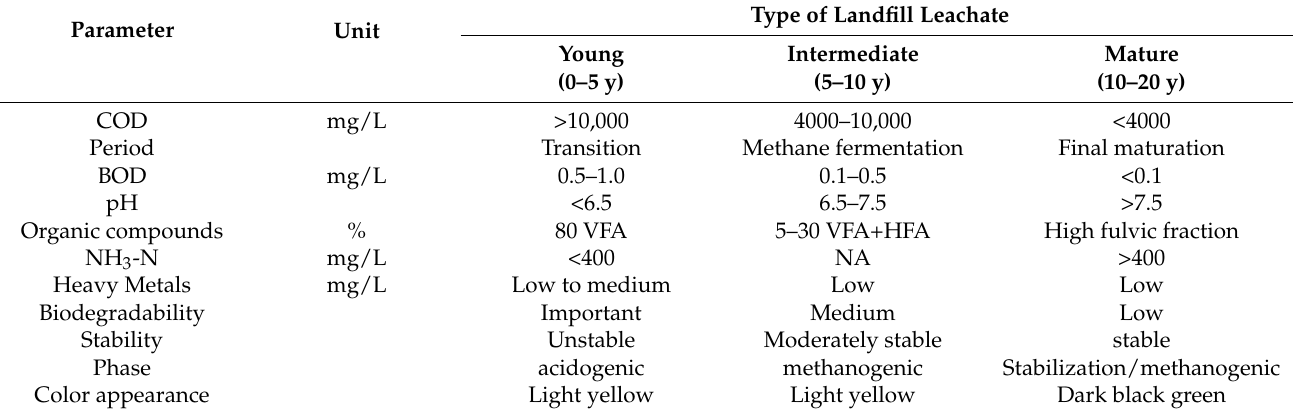
Table 1. Characteristics of different types of leachate